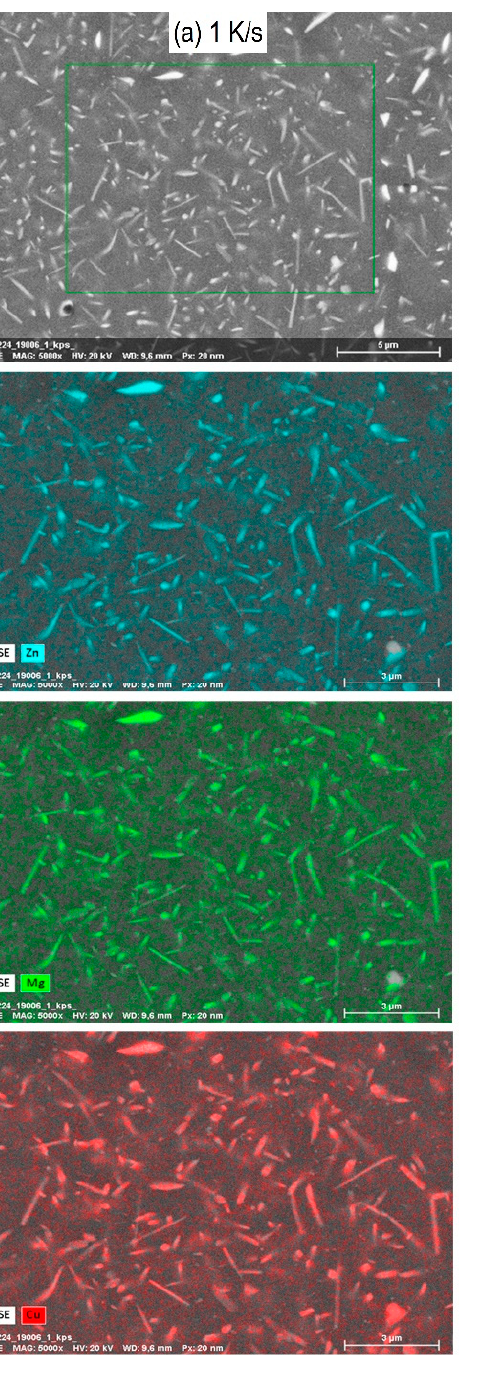
Figure 11. SEM-EDS maps for Zn, Mg, and Cu of alloy 7068 after cooling at ( a ) 1 K/s and ( b ) 10 K/s.